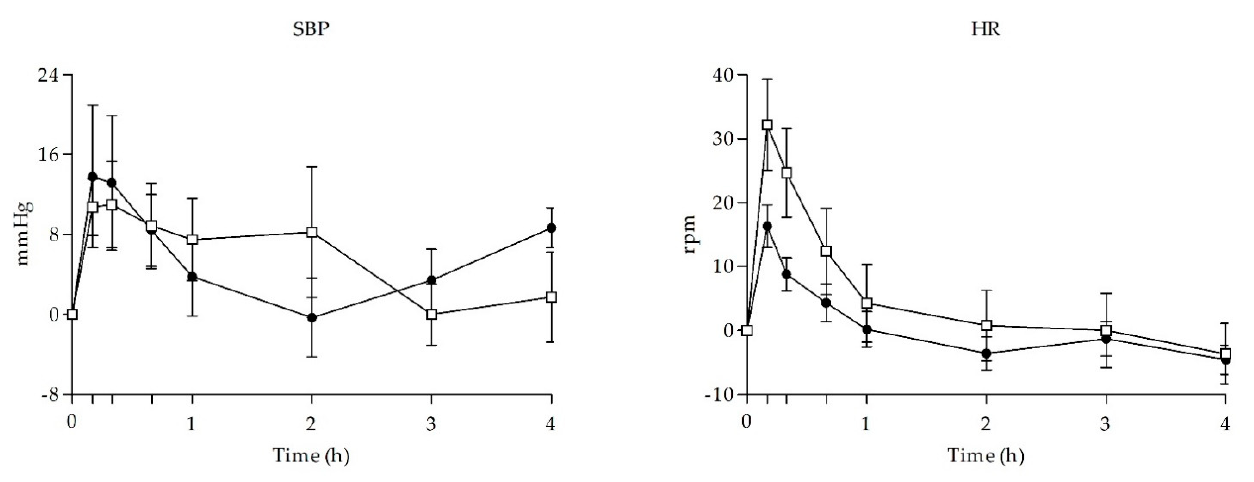
Figure 1. Time course of main physiological signs observed after self-administration of UR-144 ( n = 8) and THC ( n = 8). Values are differences from baseline. Symbols: ● UR-144, □ THC; values are mean and standard error. SBP = systolic blood pressure; HR = heart rate.